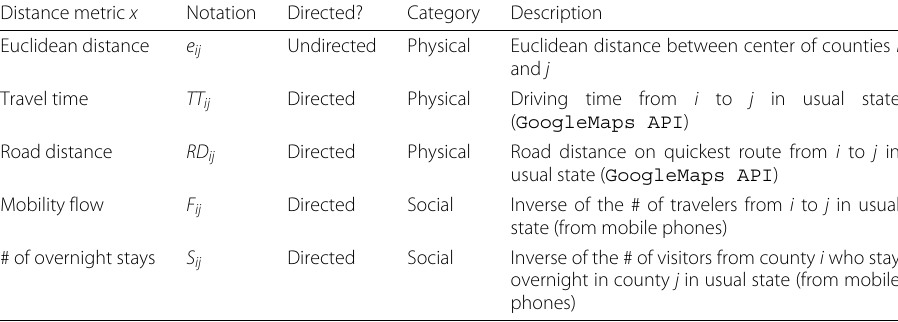
Table 2 Distance metrics x that were used as edge weights to build inter-city network N x Distance metric x Notation Directed? Category Description Euclidean distance e ij Undirected Physical Euclidean distance between center of counties i and j Travel time TT ij Directed Physical Driving time from i to j in usual state ( GoogleMaps API ) Road distance RD ij Directed Physical Road distance on quickest route from i to j in usual state ( GoogleMaps API ) Mobility flow F ij Directed Social Inverse of the # of travelers from i to j in usual state (from mobile phones) # of overnight stays S ij Directed Social Inverse of the # of visitors from county i who stay overnight in county j in usual state (from mobile